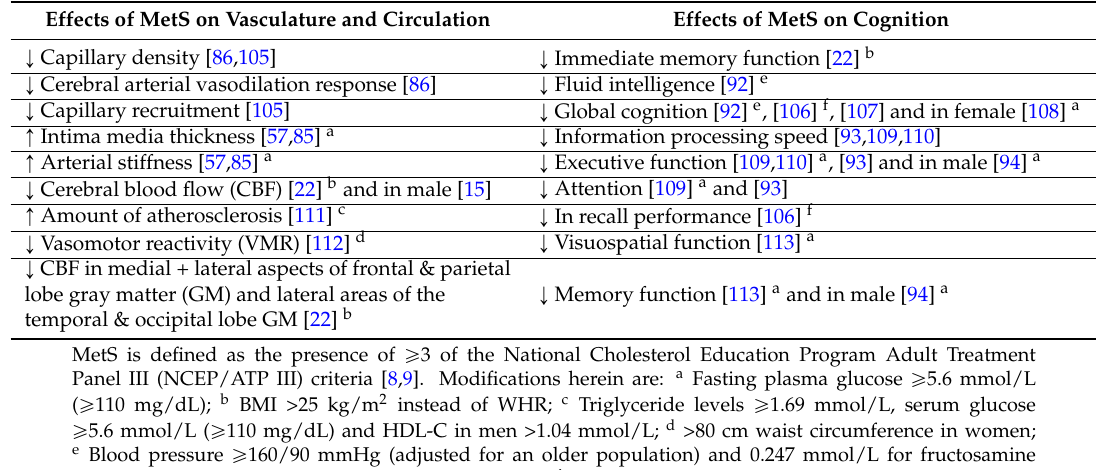
Table 1. Overview of the effects induced by MetS on vasculature and circulation as well as the effects of Metabolic Syndrome (MetS) on